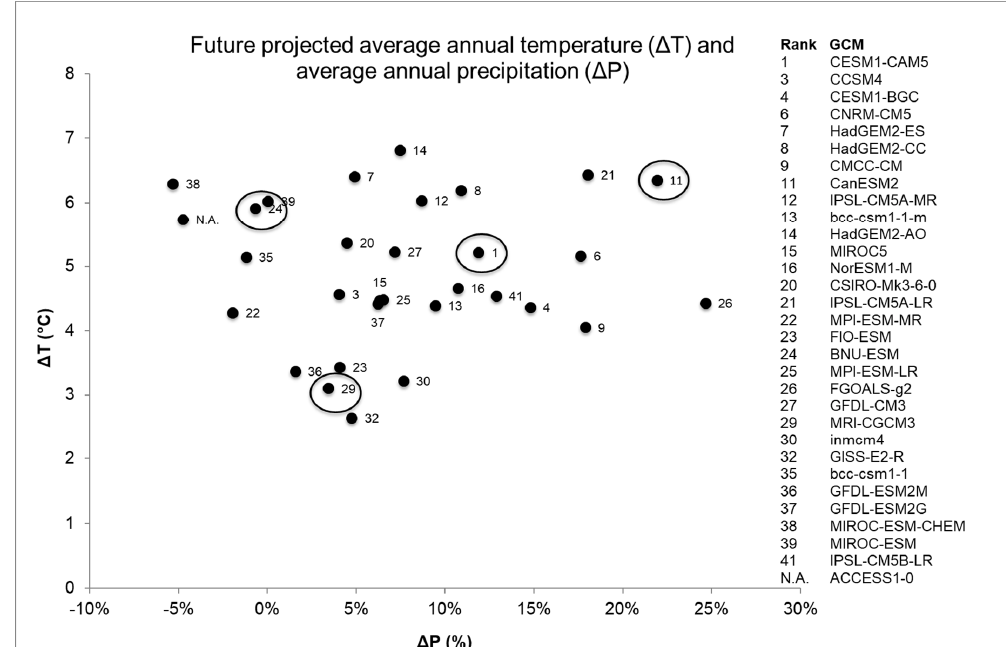
Figure 2. Projected change in average annual temperature ( ∆ T) and average annual precipitation ( ∆ P) from 31 global climate models (GCMs) between the 2070–2099 and the 1970–1999 periods for the Pacific Northwest (Oregon and Washington). ∆ T and ∆ P were calculated using the NASA NEX-DCP30 climate dataset [40]. GCMs are ranked according to model skill for simulating historical climate of the Pacific Northwest region [36]. The four GCMs used in this study are circled. ACCESS1-0 GCM was not evaluated [36].